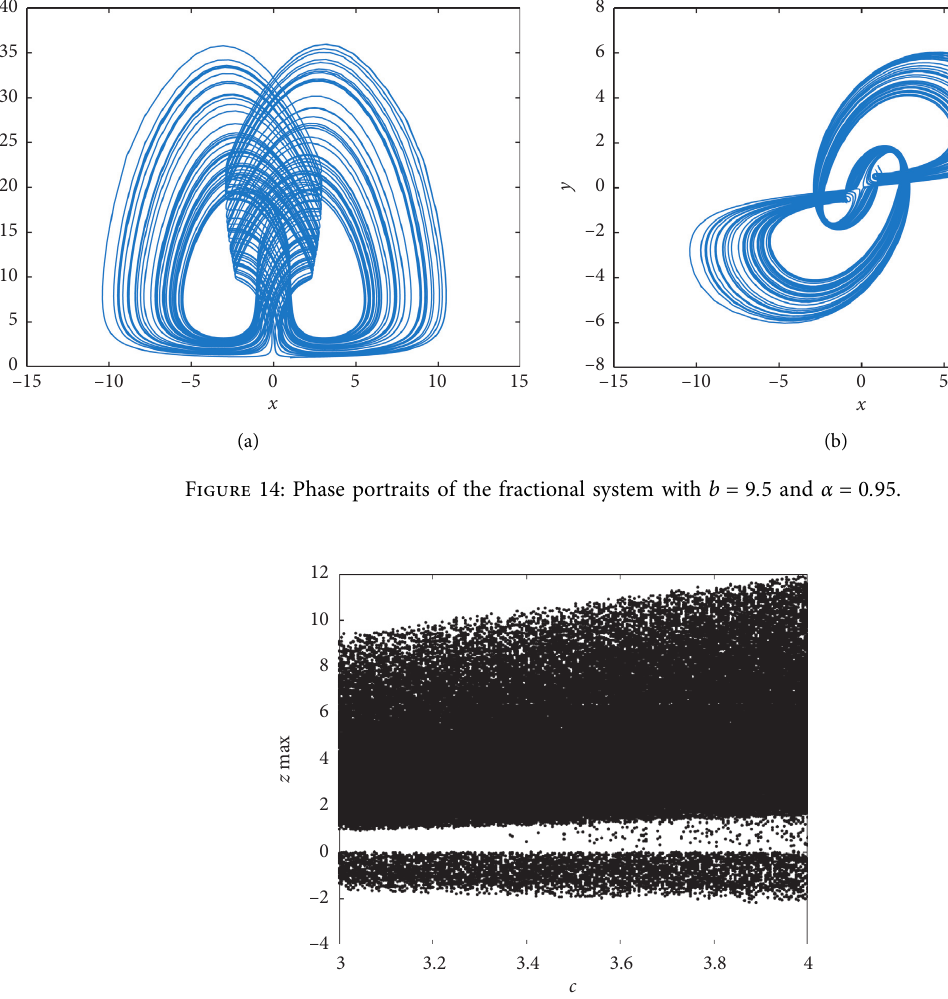
Figure 15: Bifurcation diagram according to the variation of parameter c .